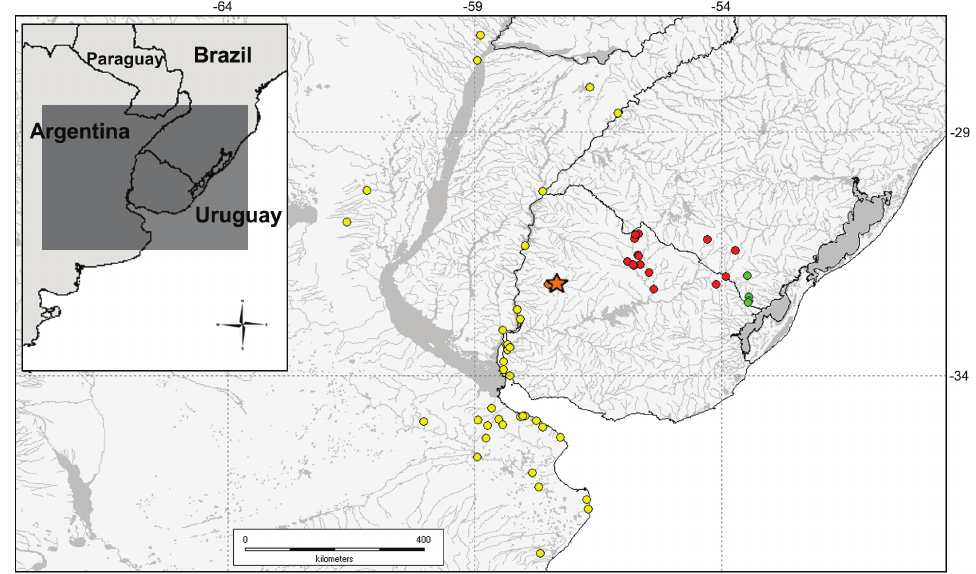
Figure 6. Geographic distribution of Austrolebias queguay sp. n. (orange dots, Uruguay river basin), A. bellottii (yellow dots, Paraná and Uruguay river basins), A. melanoorus (red dots, Negro and Yaguarón river basins), and A. univentripinnis (green dots, Yaguaron river basin). Orange star indicates type